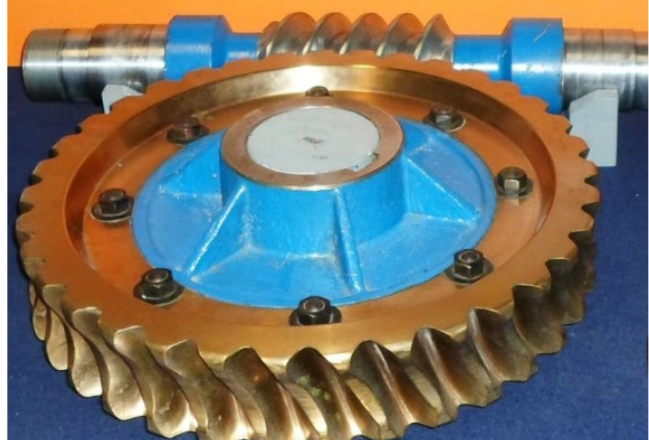
Figure 6. The manufactured worm wheel drive pair.